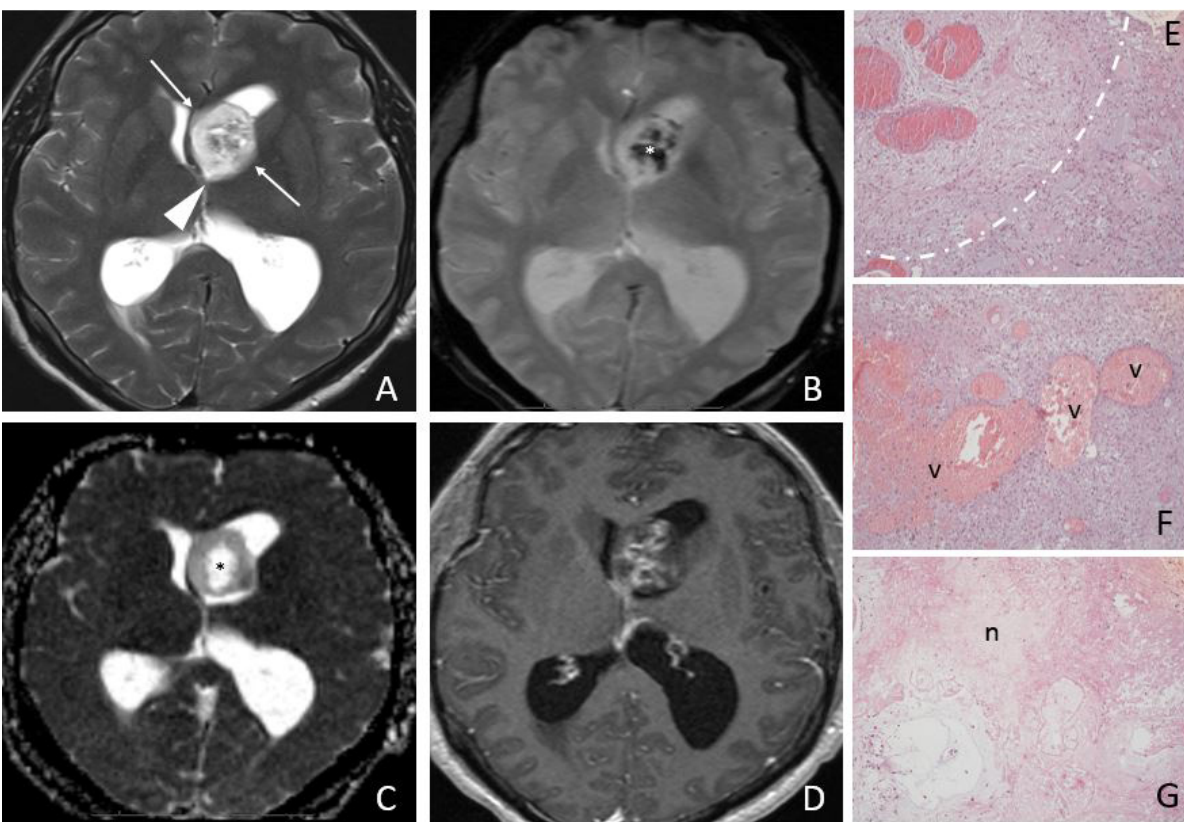
Fig. 6. Case 6. A case of supratentorial intraventricular aPA presenting with hydrocephalus, located in the left frontal ventricular horn and compressing the foramen of Monro. Axial T2-weighted (A) shows a hyperintense solid mass with heterogeneous core signal (arrows and arrowhead) and hemorrhagic deposits on T2*-weighted images (asterisk in C) indicative of necrosis. The corresponding T1-weighted image after gadolinium injection (D) shows marked inhomogeneous enhancement mostly at the level of the lesion core. Increased water diffusivity was demonstrated on the ADC map (asterisk in C). This tumor shows different histopathology patterns, varying from a relatively solid, biphasic arrangement (dashed line) alternating with compact and loose tissue textures containing mild to moderate cellularity (E), to other regions with ectatic hyalinized vessels (“v” in F). A necrotic area (n) with hemorrhage was also present